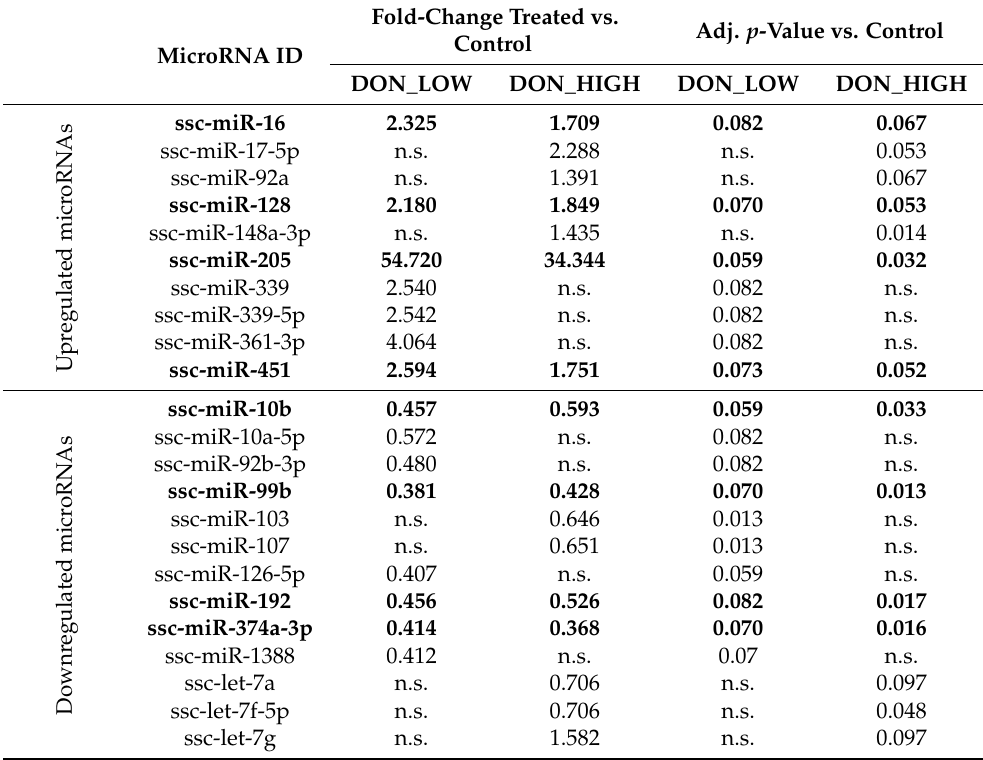
Table 1. Fold changes and adjusted p -values of microRNAs in serum samples significantly affected in the DON_LOW or DON_HIGH group compared to the Control. The eight microRNAs affected both in DON_LOW and DON_HIGH are indicated in bold. n.s., not significant (adjusted p -value > 0.1). Fold-Change Treated vs. Adj. p -Value vs. Control MicroRNA ID